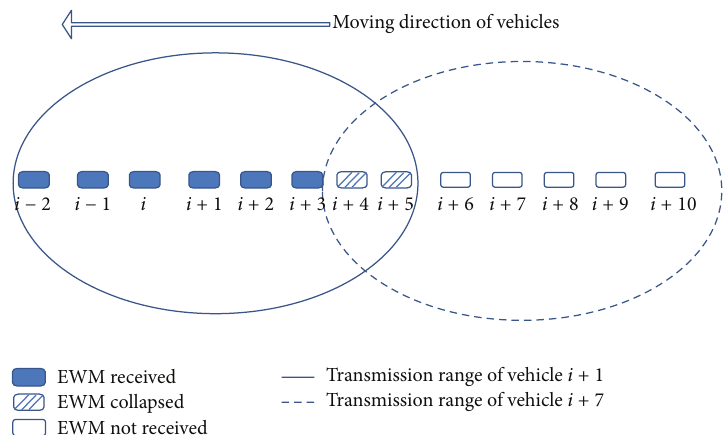
Figure 2: Interference of EWM with nonemergency